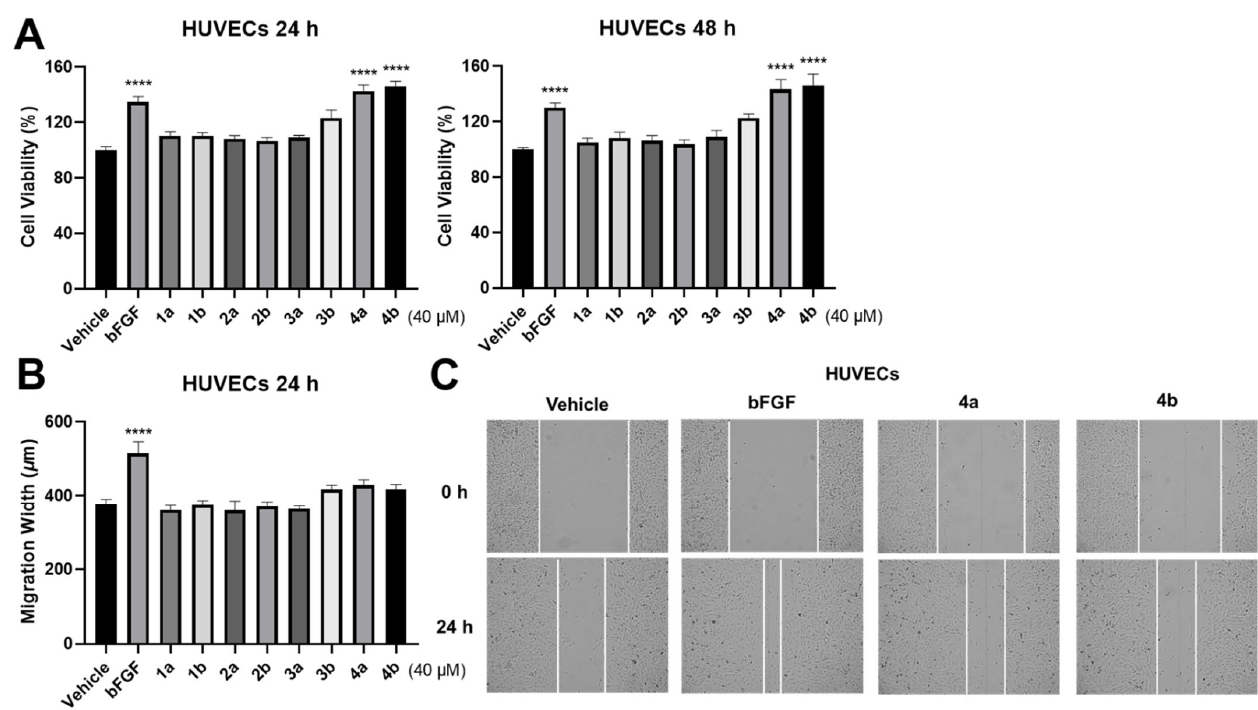
Figure 5. Promoting effects of all optically active compounds on HUVECs. ( A ) Effects of compounds on proliferation situation of HUVECs were evaluated by CCK-8 assay (40 µ M compounds or DMSO). ( B , C ) Treatment of compounds on HUVECs did not affect cell migration. The data are means ± SEM; n ≥ 3. **** p ≤ 0.0001 versus the vehicle group (one-way ANOVA). Basic fibroblast growth factor (bFGF) (100 ng/mL) was used as a positive control.